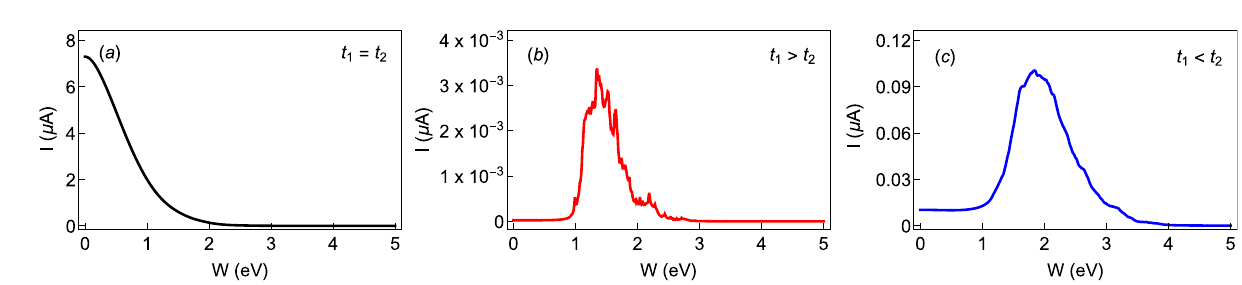
t 1 = t 2 = 1 , ( b ) t 1 = 1 , t 2 = 0.5 , and ( c ) t 1 = 1 , t 2 = 1.5 . The ring size N = 20 . The currents are averaged over 1000 distinct random configurations.